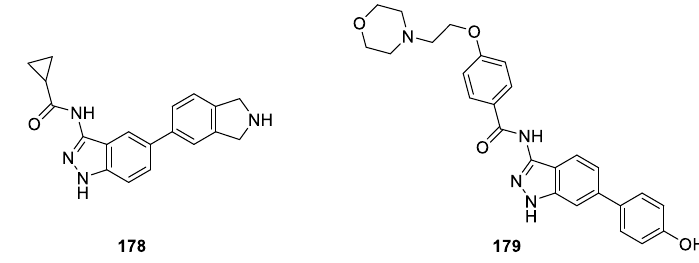
Figure 58. Chemical structures of 1 H -indazole analogues 178 and 179.